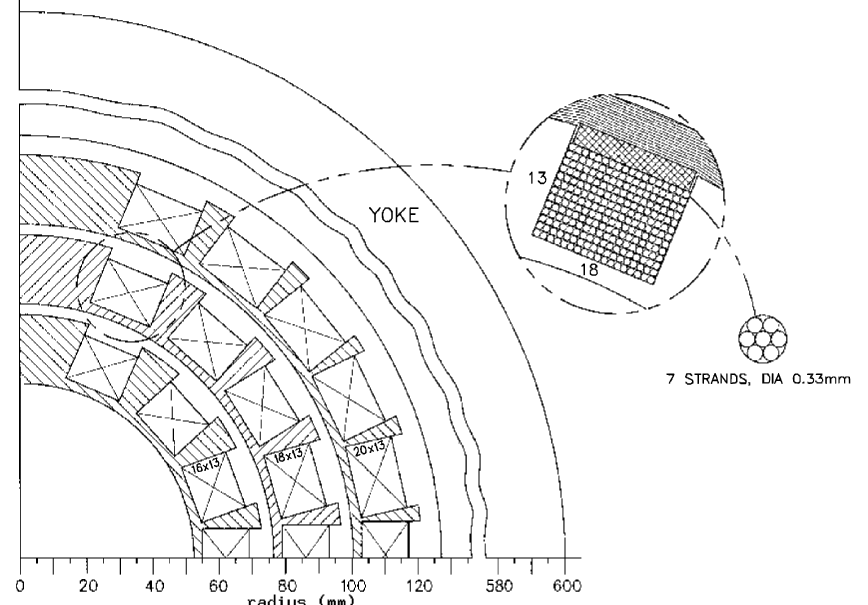
FIG. 56. Cross section of alternative high field slot dipole made with Nb 3 Sn conductor.